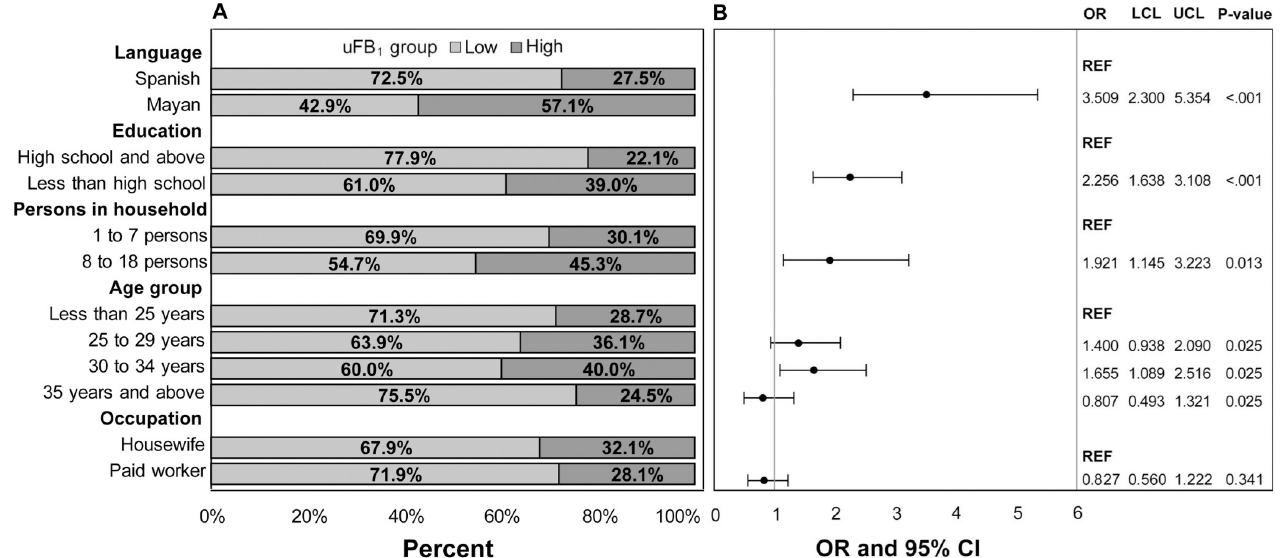
Fig 3. A Sociodemographic characteristics by low ( < 0.5 ng/ml) or high ( � 0.5 ng/ml) uFB 1 groups. B Univariable results for sociodemographic characteristics, including odds ratios (OR), upper (UCL) and lower (LCL) 95% confidence levels, and p-values from logistic regression.